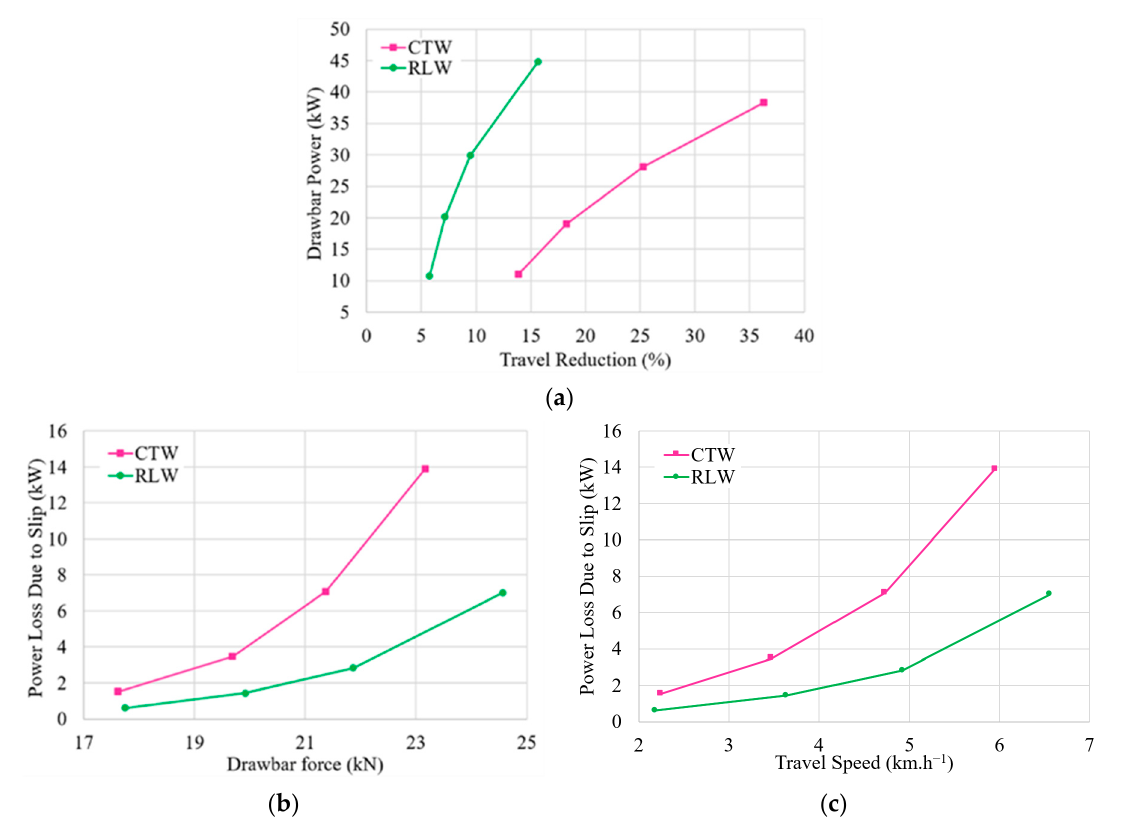
Figure 7. Drawbar power delivered and power lost by test tractor with CTW and RLW, comparison charts ( a ) drawbar power against travel reduction and power losses against ( b ) drawbar force, and ( c ) travel speed.